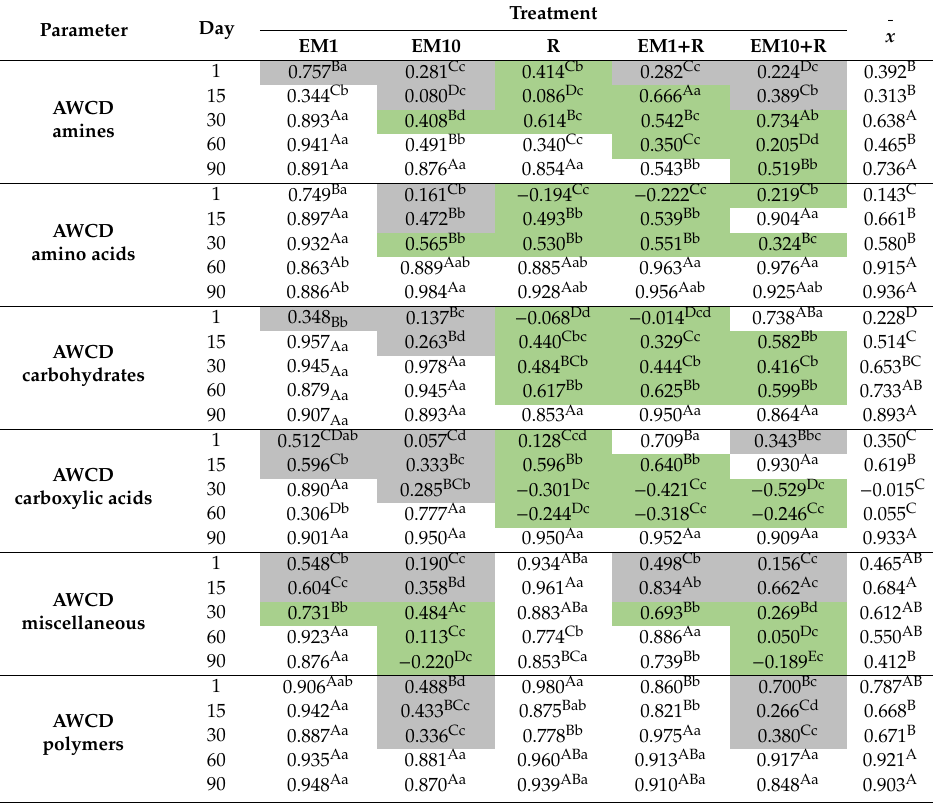
Table 6. The resistance (RS) index for the carbon substrate